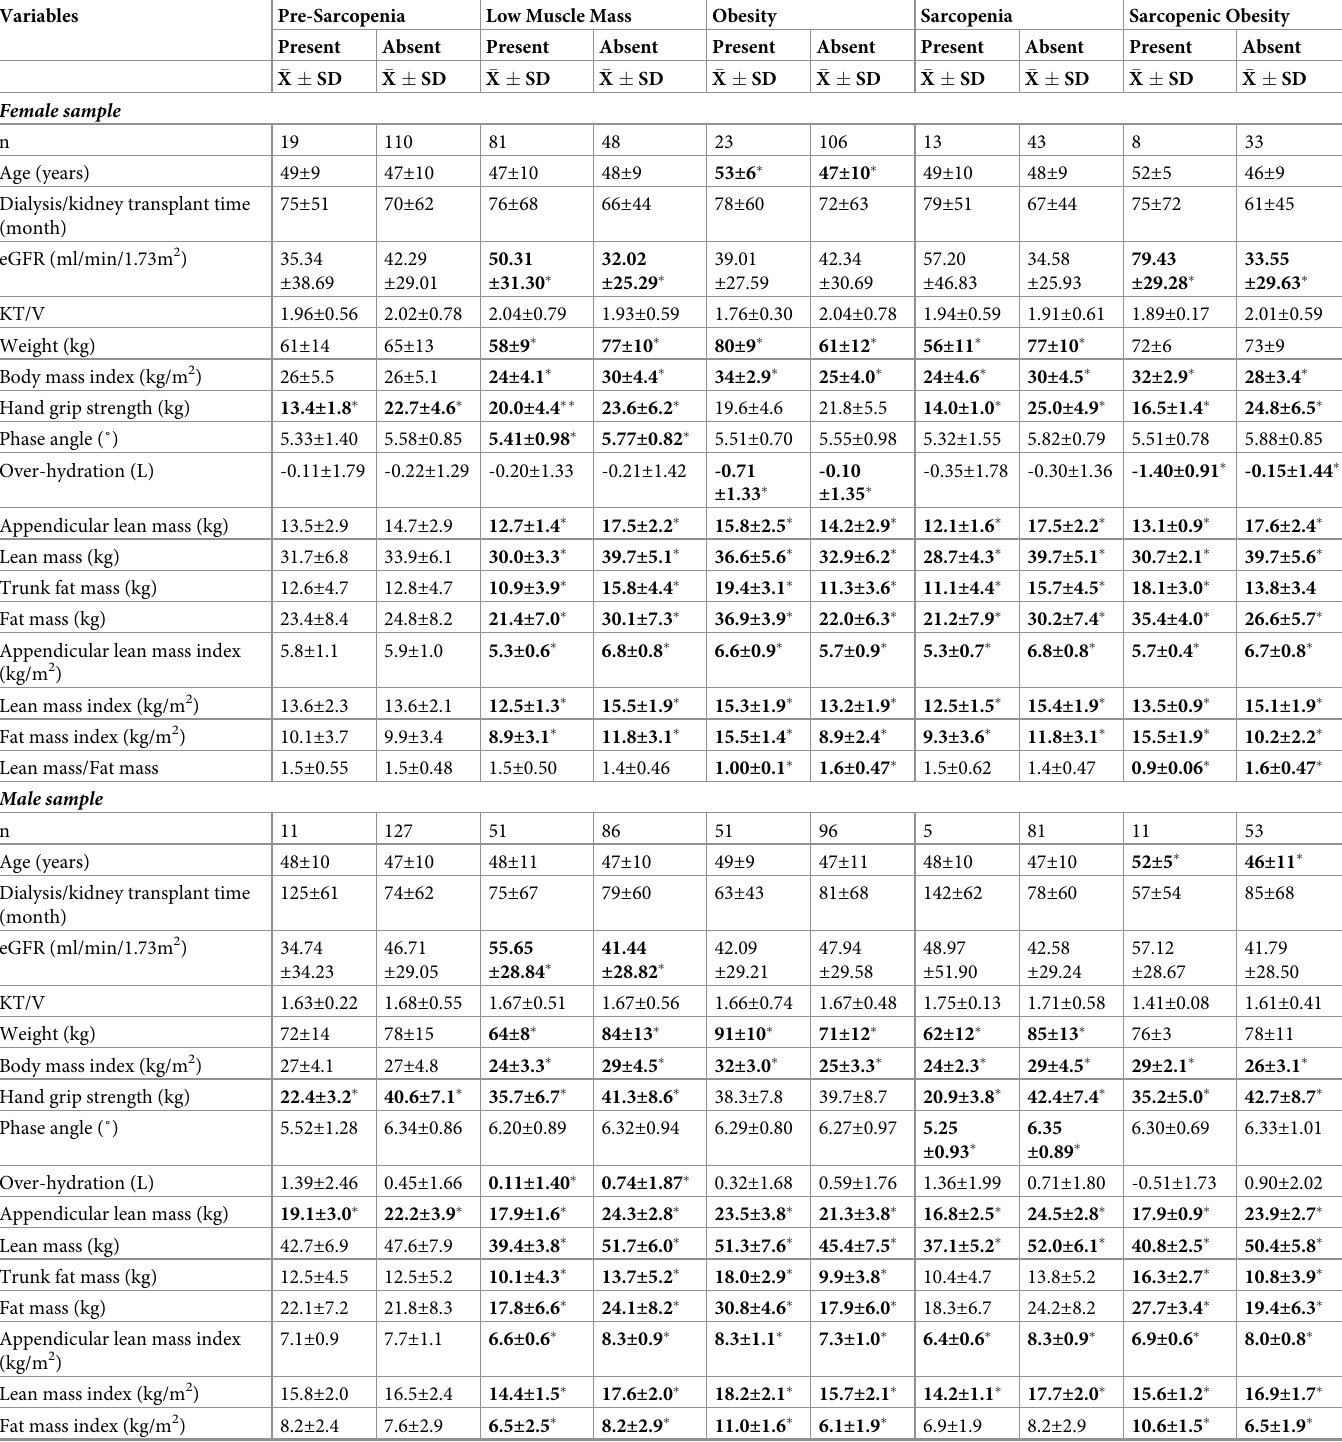
Table 1. Descriptive data of official diagnostic of pre-sarcopenia, low muscle mass, obesity, sarcopenia and sarcopenic obesity stratified by sex.